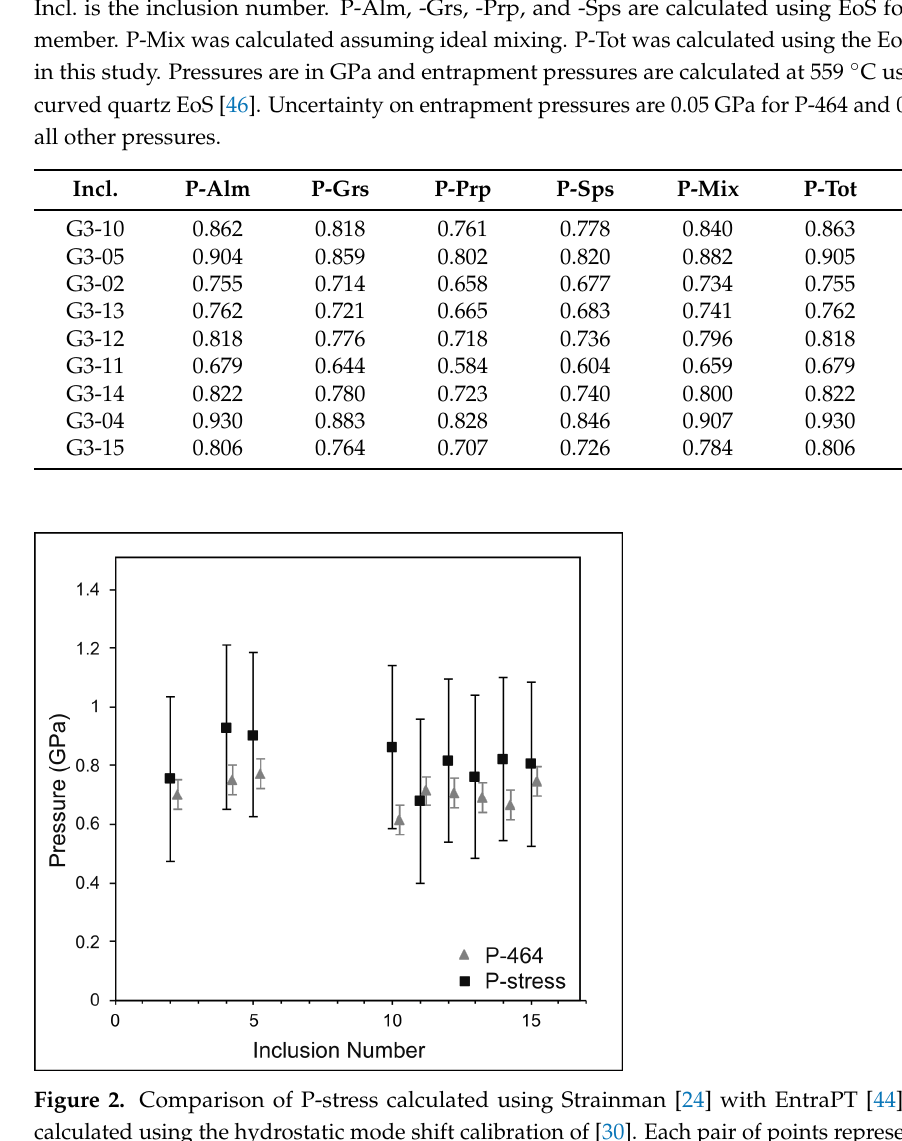
Table 3. Entrapment pressures calculated using different EoS and the inclusion pressures above. assumes hydrostatic stress. This pressure was calculated with the EoS produced in this study.